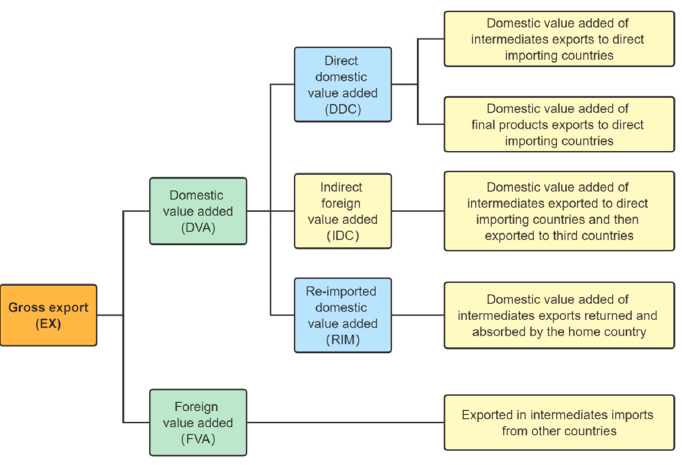
Figure 2. Decomposition of value-added in gross exports based on the OECD database.